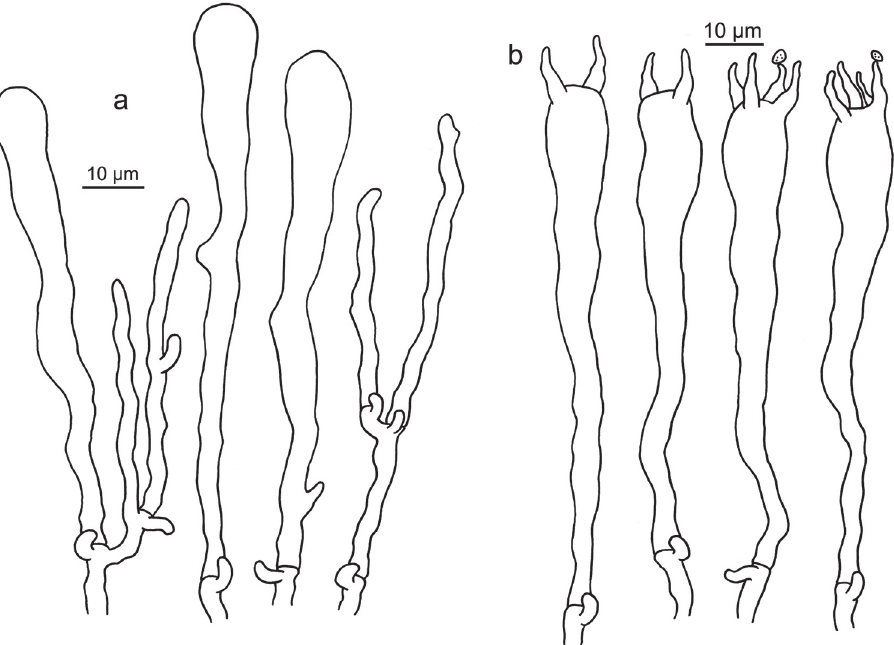
Figure 7. Microscopic features of Clavariadelphus amplus (HKAS 54876, holotype). a Leptocystidia and immature basidia b